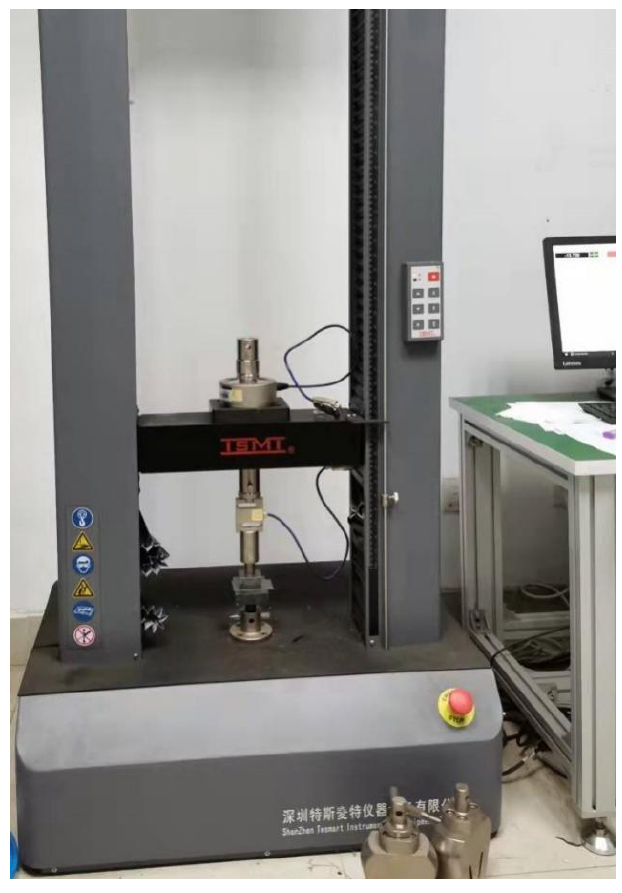
Figure 7. Universal testing machine and test probe.